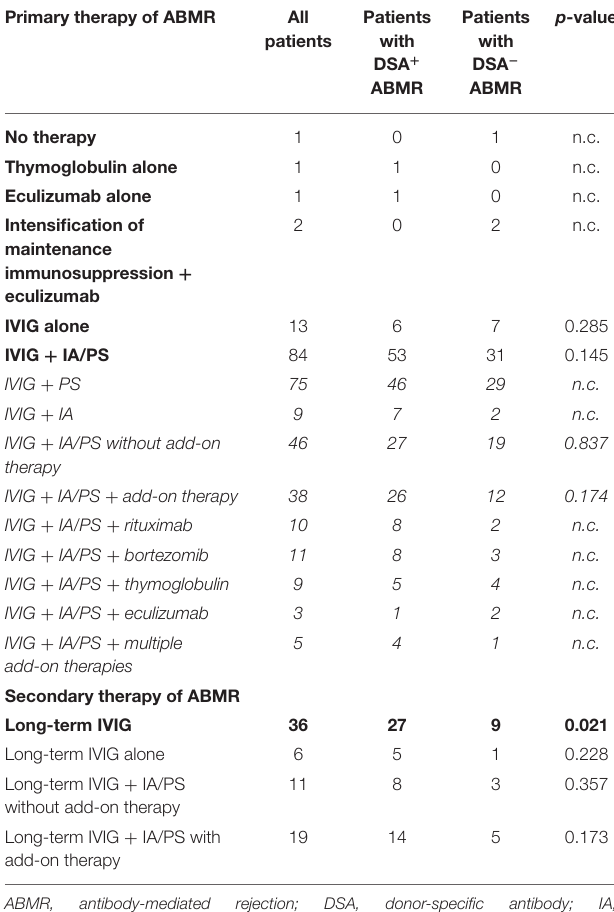
TABLE 1 | Overview of therapies used to treat biopsy-proven antibody-mediated rejection among 102 renal allograft recipients. Primary therapy of ABMR All